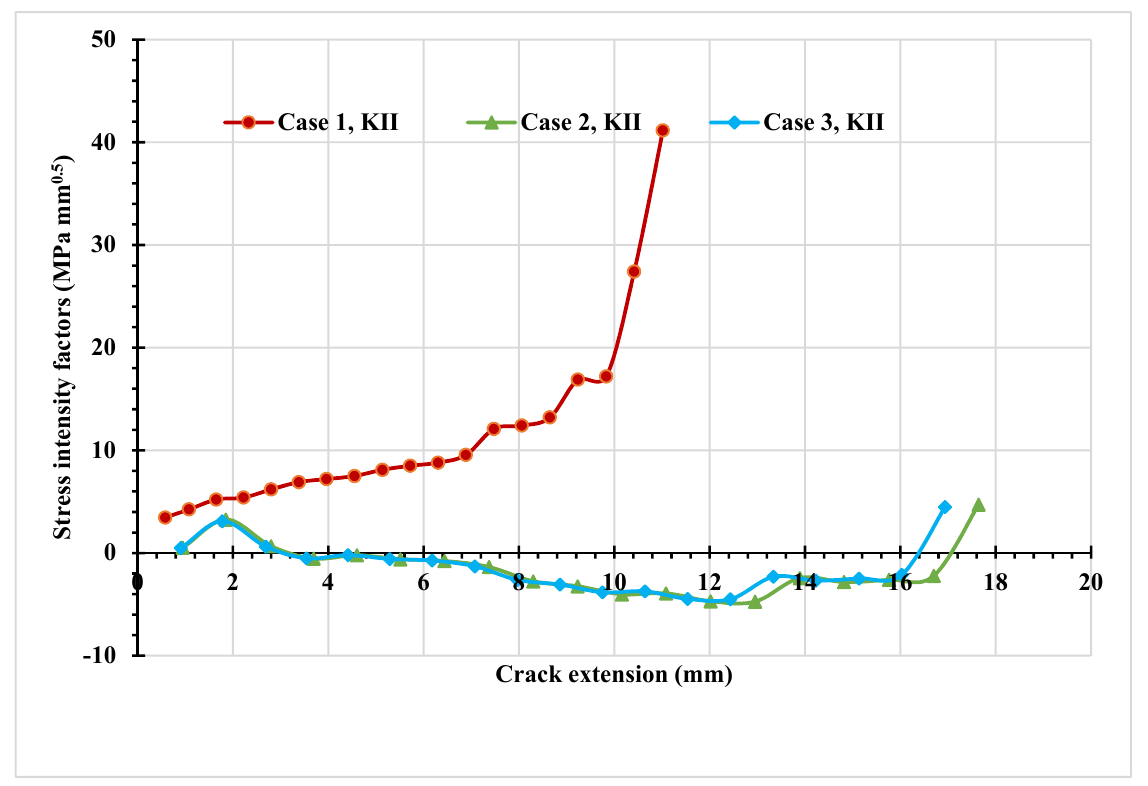
Figure 22. Predicted values of K II for the three different cases.